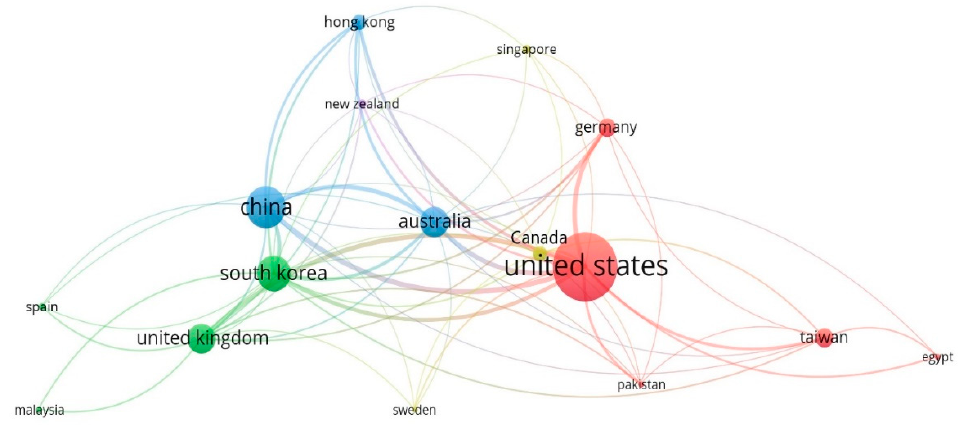
Figure 3. Network of countries / regions.